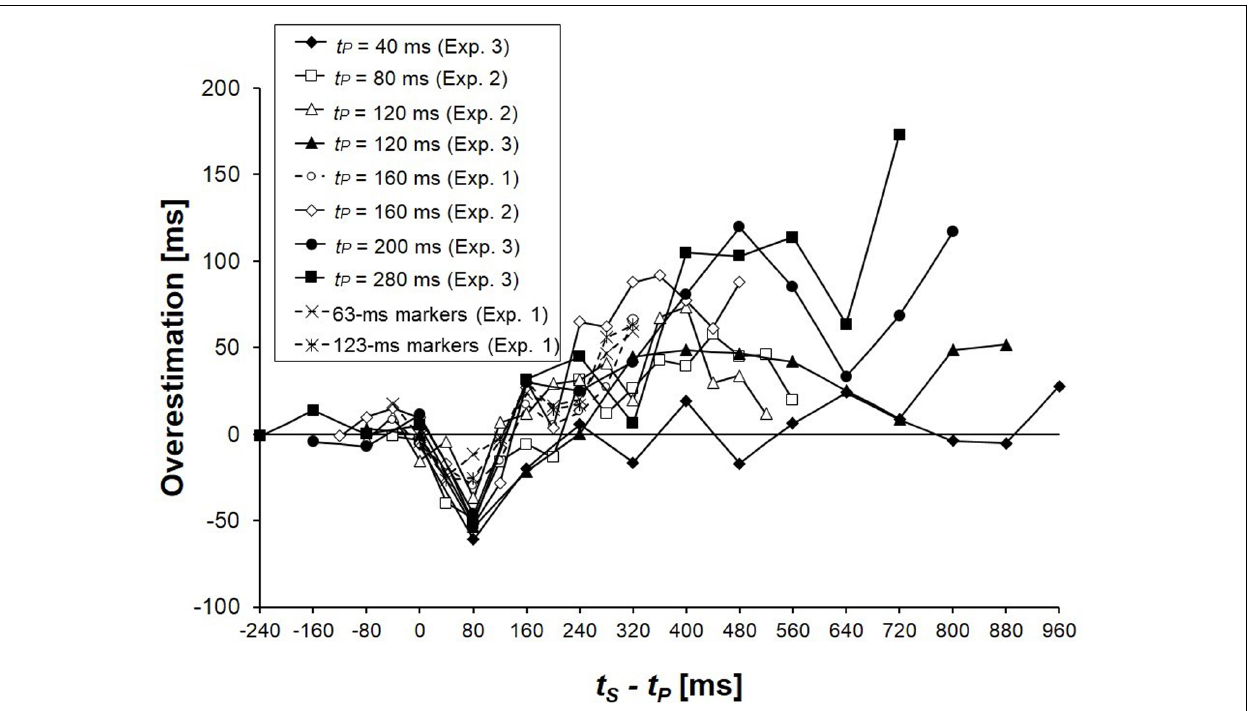
FIGURE 6 | Overestimations of t S as functions of t S − t P in Experiments 1, 2, and 3. The overestimations were calculated as the increases of PSEs due to the presence of t P